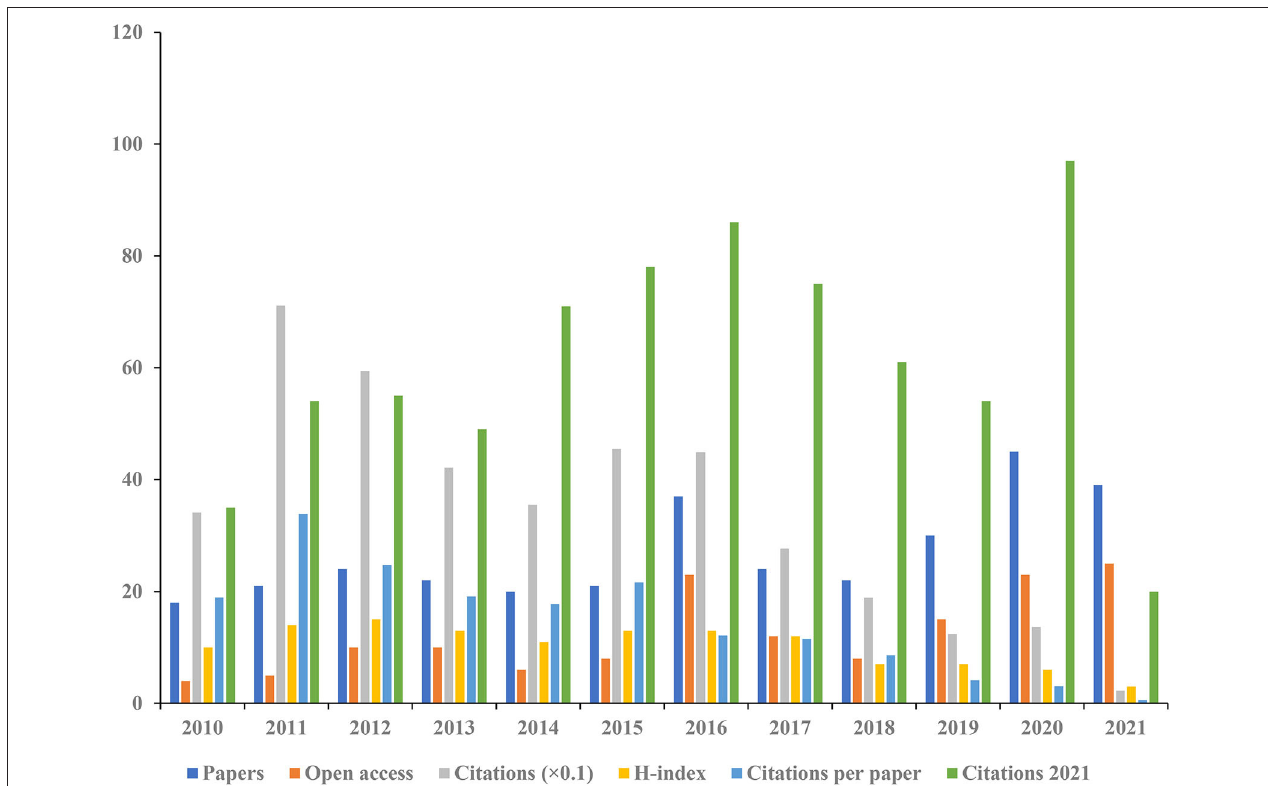
FIGURE 3 | The number of articles, open-access articles, citations, citations per article, citations in 2021, and H-index for each